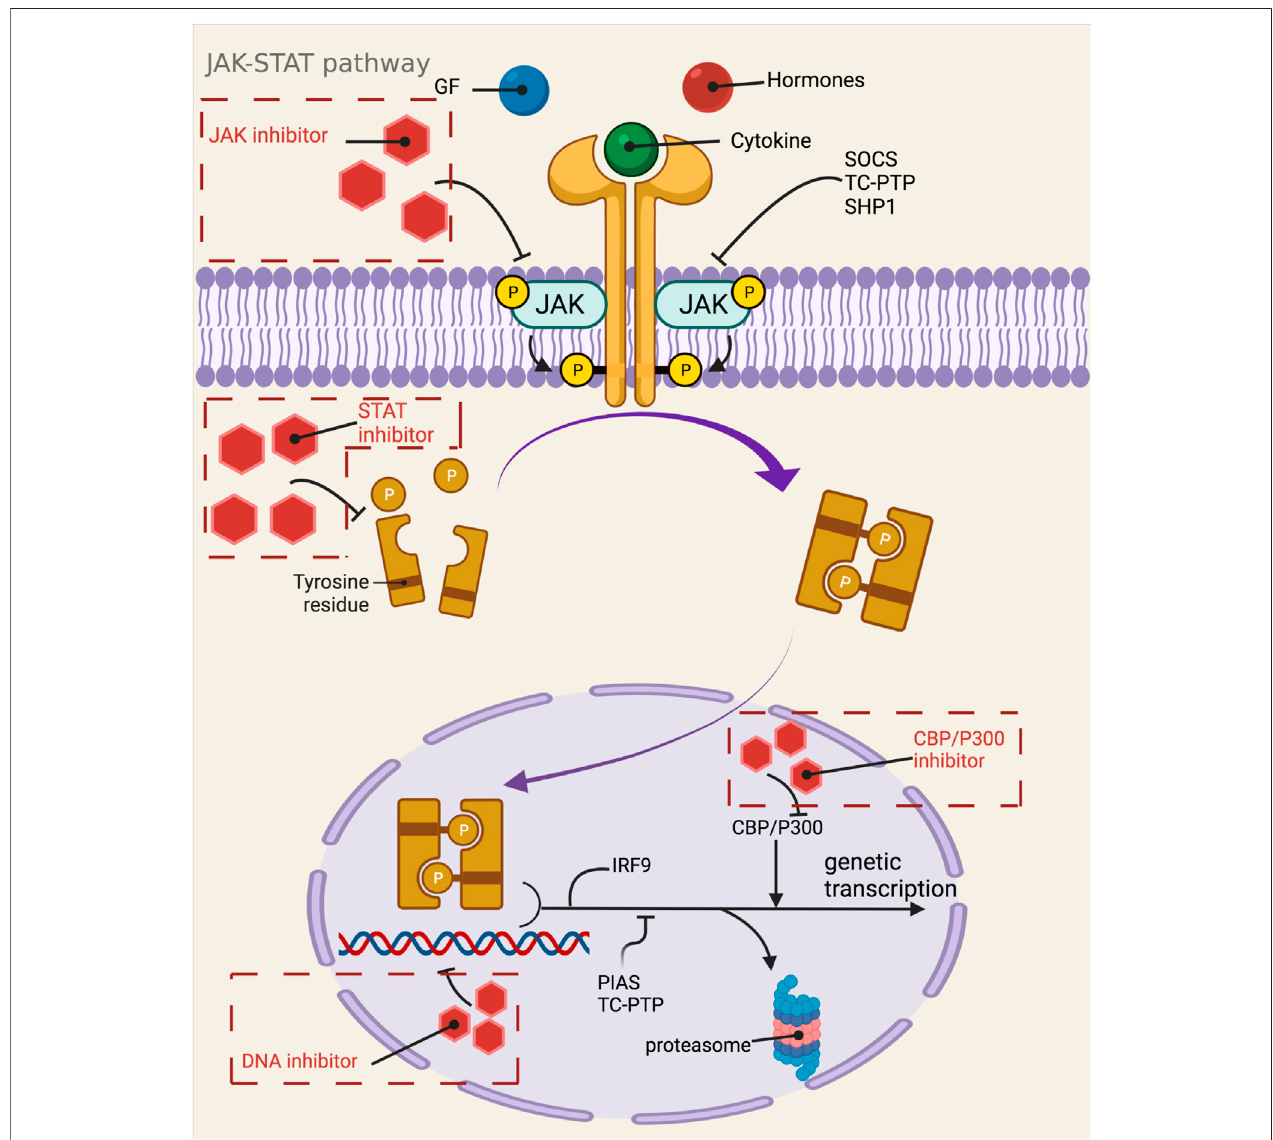
FIGURE 1 | Mechanistic map of the JAK-STAT signaling pathway. CBP, calmodulin-binding peptide; GF, growth factor; IRF9, interferon regulatory factor 9; PIAS, protein inhibitor of activated STAT; SHP1, Src homology region 2 domain-containing phosphatase 1; SOCS, suppressor of cytokine siganaling; TC-PTP, T-cell protein tyrosine phosphatase. The fi gure is created with